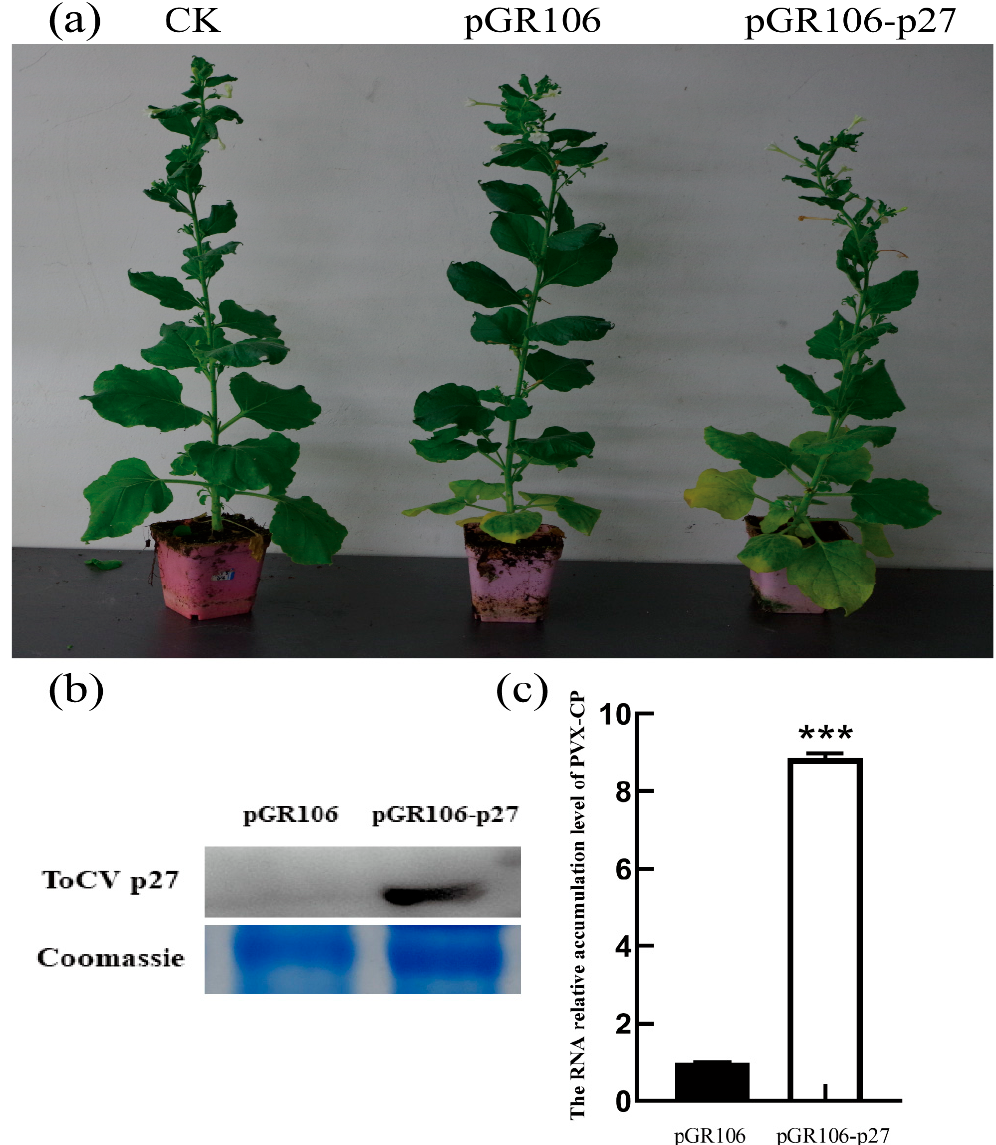
Figure 2. Expression of the ToCV p27 protein in N. benthamiana after inoculation with pGR106-p27. ( a ) On the 14th day after inoculation, the symptoms of N. benthamiana were inoculated with pGR106 and the pGR106-p27 virus. ( b ) Expression of the ToCV p27 protein in N. benthamiana 14 days after inoculation with pGR106-p27. ( c ) The accumulation of PVX CP in N. benthamiana was determined by qRT-PCR at 14 dpi. Error bars indicate standard deviation and statistical significance was calculated with Student’s t-test (*** p < 0.001).